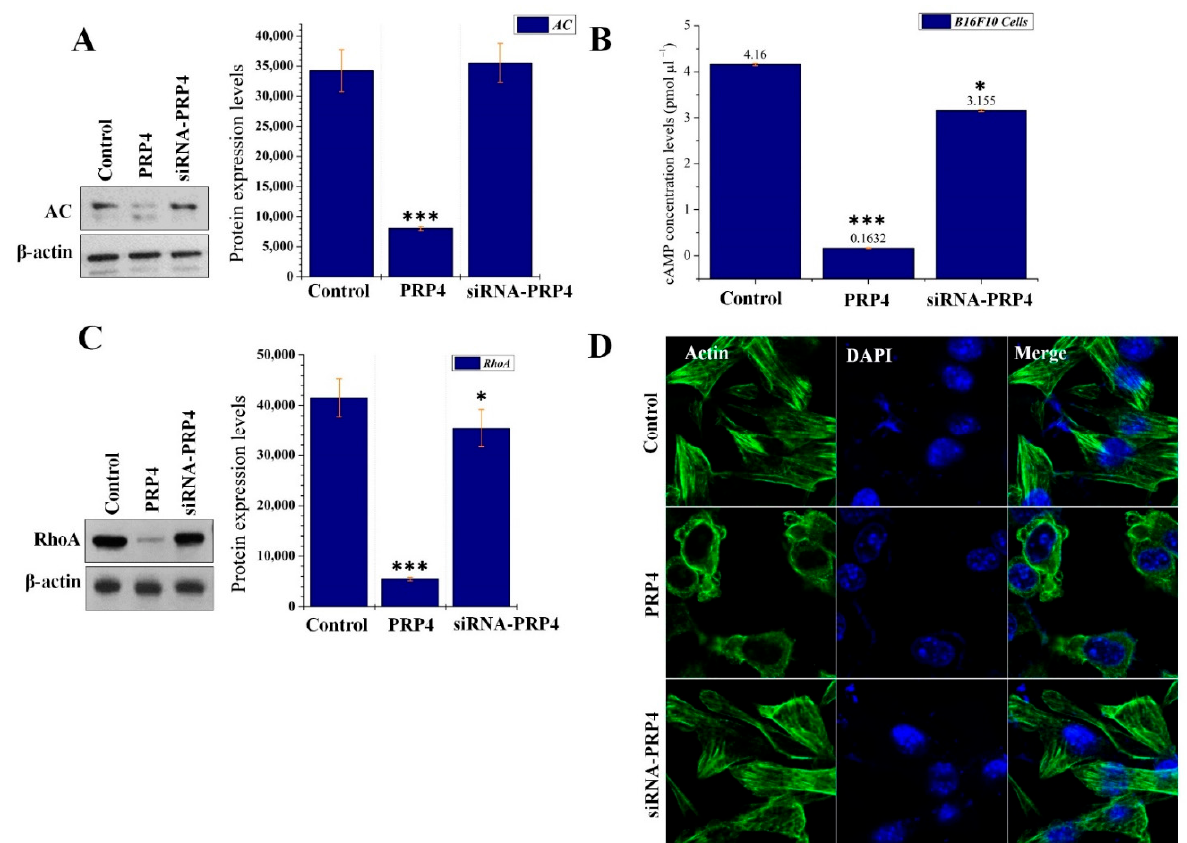
Figure 6. PRP4 alters the morphology of B16F10 cells. ( A,C ) Solubilized proteins (20 μ g) from PRP4 and siRNA-PRP4-transfected cultured cells were subjected to Western blot analysis using the corresponding antibodies for detection of respective adenylyl cyclase and RhoA proteins. The blot was simultaneously incubated with an anti-proteins antibody to show that each electrophoretic lane was loaded with the same amount of protein. β -actin was used as a standard. * p < 0.05, *** p < 0.001. ( B ) Corresponding cells were observed for cAMP levels using a cAMP assay kit, and plated cells were measured in a microplate reader (OD 450 nm). * p < 0.05, *** p < 0.001. ( D ) PRP4 and siRNA-PRP4 transfected B16F10 cells were stained with Alexa Fluor™ 488 Phalloidin to observe the structure of actin stress fiber formation. Nuclei were counterstained with DAPI, and cells were imaged using a confocal microscope (Carl Zeiss).